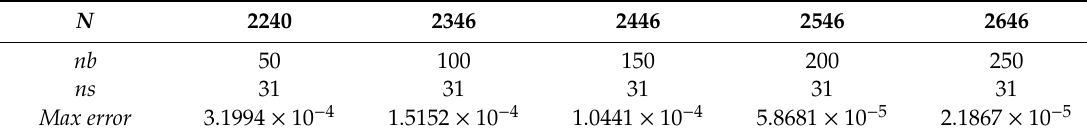
Table 7. Maximum absolute error for case 6.